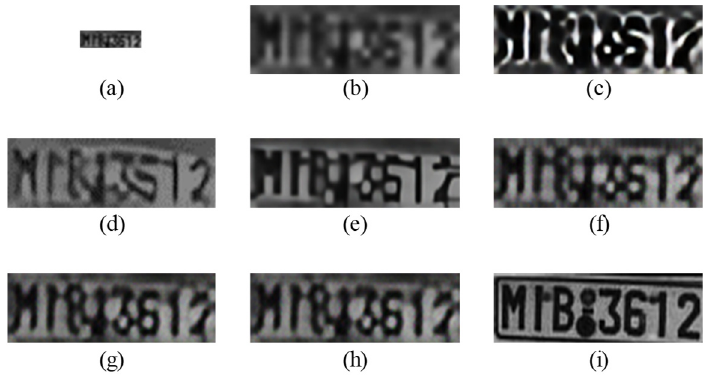
Figure 11. SR results on the LP image of the Greek vehicle dataset for scale factor ( × 4): ( a ) input low-quality legacy image (24 × 8), ( b ) Bicubic (96 × 32), ( c ) MZSR, ( d ) DRN, ( e ) SwinIR, ( f ) HIFA-LPR (Step 1), ( g ) HIFA-LPR (Step 2), ( h ) HIFA-LPR (Step 3), ( i ) HR image.